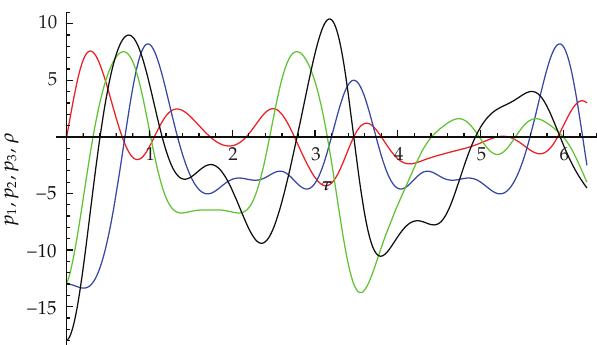
Figure 21: The plot of the EoS (cid:2) 4.17 (cid:3) , t ∈ (cid:4) 0 , 2 π (cid:5) , k (cid:6) 1 / 3, ρ (cid:2) red (cid:3) , p 1 (cid:2) blue (cid:3) , p 2 (cid:2) green (cid:3) , p 3 (cid:2) black (cid:3) .